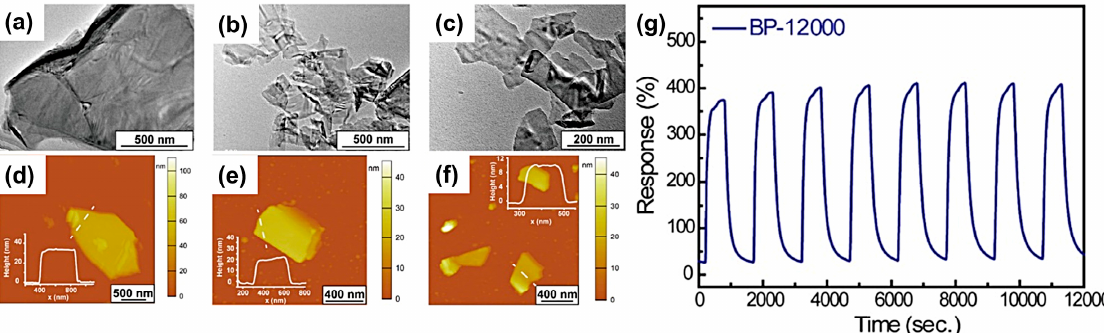
Figure 7. Characterization using ( a – c ) TEM images and ( d – f ) AFM graphs of BP-4000 ( a , d ), BP-7000 ( b , e ), and BP-12,000 ( c , f ) samples. ( g ) dynamic response of BP-12,000 under 1000 ppb NO 2 exposure showing complete recovery over eight cycles. Reprinted with permission from Ref. [78]. Copyright 2020, American Chemical Society.